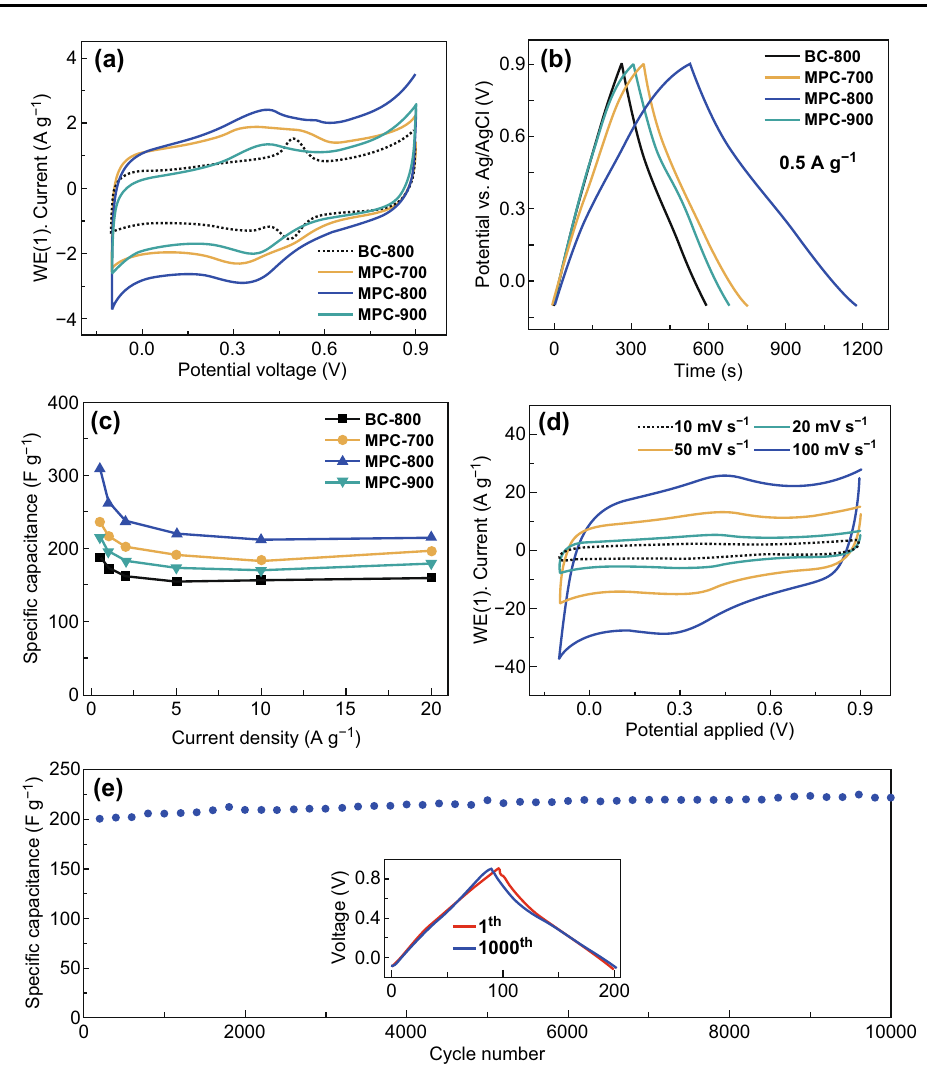
Fig. 3 Electrochemical performance of the MPC series in a three‑electrode system. a CV curves of MPC series at 10 mV s −1 . b Charge/dis‑ charge curves at 0.5 A g −1 . c Specific capacitance versus current density. d CV curves of MPC‑800 at various scan rates (10–100 mV s −1 ). e Long‑term cycle performance and Coulombic efficiency of MPC‑800 at 10 A g −1 with charge/discharge curves before and after 10,000